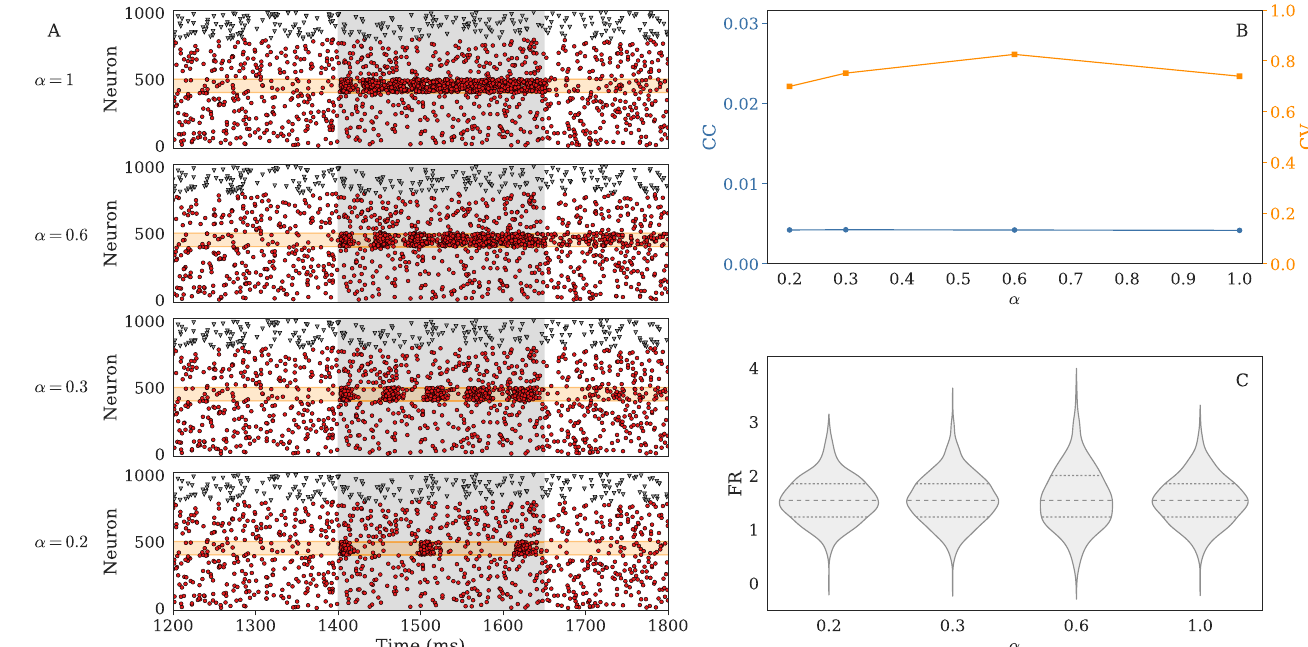
Fig 5. Decrease in health can be partly compensated by homeostatic mechanisms and be invisible from the statistical properties of background activity, as shown by the behavior on an excitatory and inhibitory population with N = 1000 neurons in the asynchronous irregular (AI) state. A . For such a network, changes in the neuronal health, modeled by a decrease in the α parameter, do not appear in the background activity of the raster (non-grayed areas), where the activity of both excitatory (red circles) and inhibitory (gray triangles) neurons remain very similar. To see the actual consequences of the decrease in health, one must look at the response of the network to an additional input, which is shown in the grayed areas on panel A. In response to a threefold increase in the rate of Poisson input between 1400 and 1650 ms, the activity of 100 excitatory neurons (marked by the orange area) progressively switches from continuous tonic firing (top) to well- separated bursts (bottom). B . More quantitative analyses also confirm that the background activity remains close to Poissonian, with coefficients of variation (CVs) ffiffiffiffi p around 0.7–0.8, and asynchronous, with an average cross-correlation (CC) smaller than 1 = . C . The distributions of firing rates over 5 seconds remain almost N identical and centered around 2 Hz; dotted and dashed lines respectively denote the quartiles and